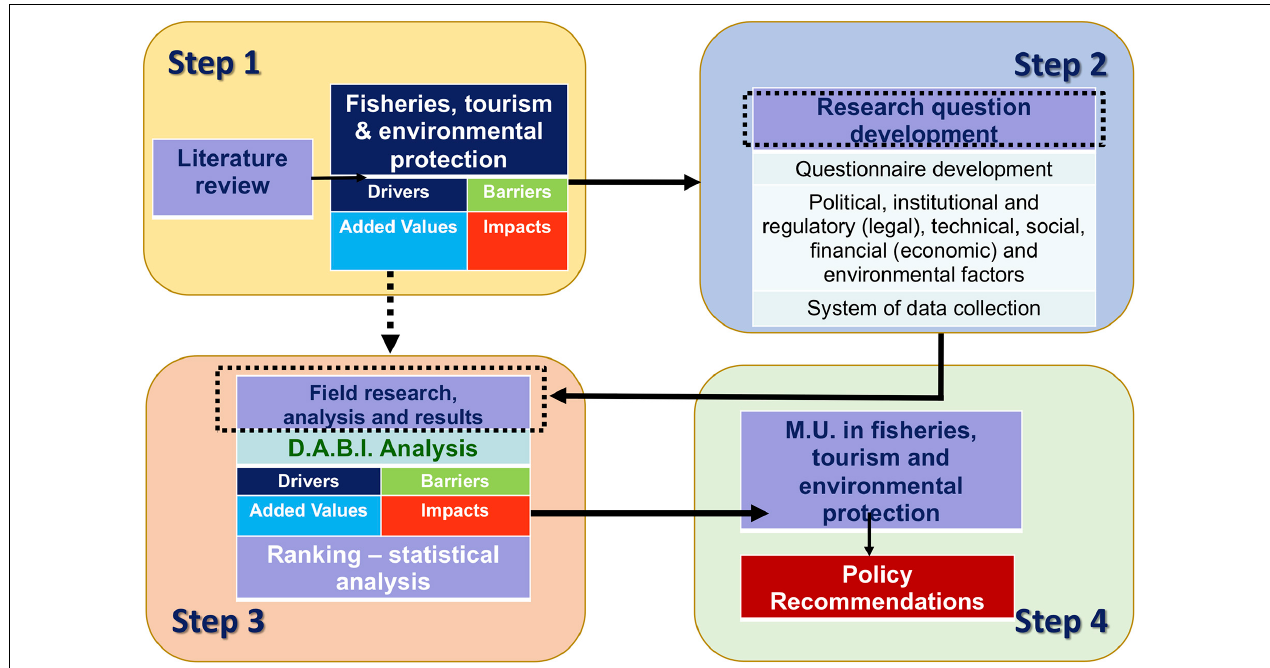
FIGURE 2 | The research methodology. Source: Own elaboration by the